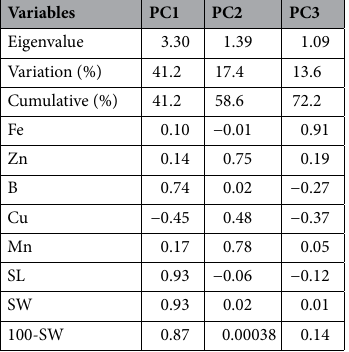
Table 3. Eigenvectors and eigenvalues of the first three principal components of 8 traits.